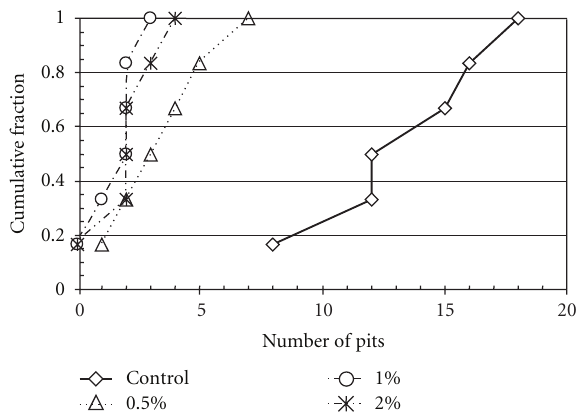
Figure 3: Cumulative fraction of number of pits formed after the end of the experiment for all SCH electrochemical cells [7].